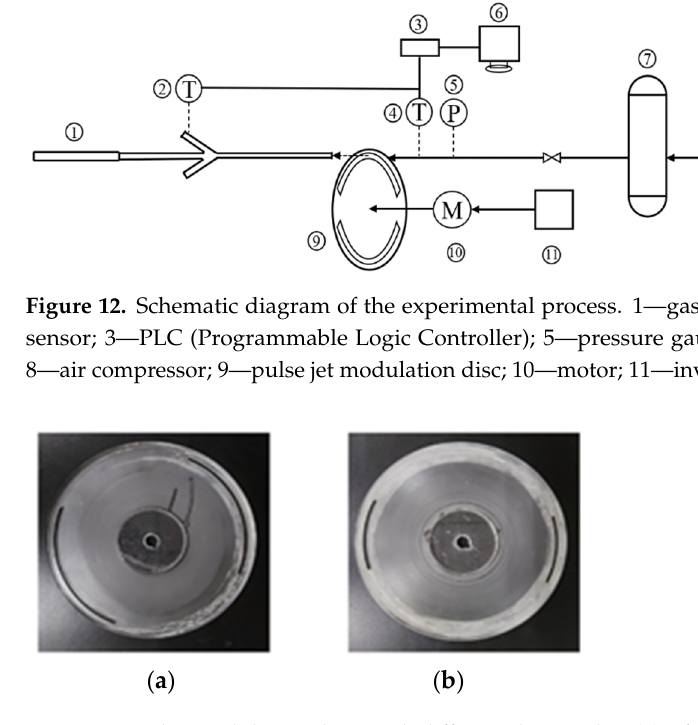
( c ) Figure 14. Different types of chambers: ( a ) traditional chamber; ( b ) end wave chamber; ( c ) Helm- holtz chamber. 5.2. Experimental Results and Analysis In the actual experiment, the ambient temperature was uncontrollable and was dif- ferent from the idealized instantaneous ejection into the gas wave tube and instantaneous exhaust used in the simulation. For a certain distance between the nozzle and the gas wave tube opening, the jet caused a certain degree of loss before entering the gas wave tube, which, along with other complications, made the refrigeration efficiency obtained by the experiment lower than the value obtained by the simulation. The pressure sensor (5) was inserted into the air supply pipe close to the nozzle to measure the total pressure P in at the inlet of the air wave pipe. The valve was used to adjust the pressure to 0.1 and 0.2 MPa. The exhaust static pressure was the atmospheric pressure, and the corresponding expansion ratios ε were close to 2 and 3, respectively. A temperature sensor (4) was also inserted into the air supply pipe close to the nozzle for measurement, which was used as the total intake temperature T out . For the measurement of the cooling temperature of the outlet air, because the modulation disc 9 was attached to the arc-shaped groove on the end of the gas wave tube, the pulse exhaust and reflection caused by the speed change made it difficult to accurately measure the exhaust tempera- ture in the edge area of the pulse jet modulation disc. Therefore, this experiment adopted an indirect method that involved setting a flow channel near the opening of the gas wave tube, inserting a temperature sensor (2), measuring the time-average temperature T a near the opening, and then approximately converting to the exhaust temperature T out . Alt- hough the accurate refrigeration temperature cannot be measured in this way, it is clear enough that the measurement results of uniform conditions can be used to compare the refrigeration efficiency of various gas wave tubes. Because the room temperature injection gas and the refrigerating gas alternately pass through the opening of the gas wave tube, and the ambient gas outside the metal gas wave tube heats the small amount of refrigerating gas, the time-average temperature T a meas- ured at the opening of the gas wave tube is much higher than the actual cooling discharge